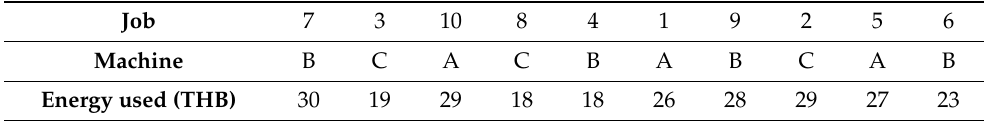
Table 4. Results of the proposed decoding method in Step 3.